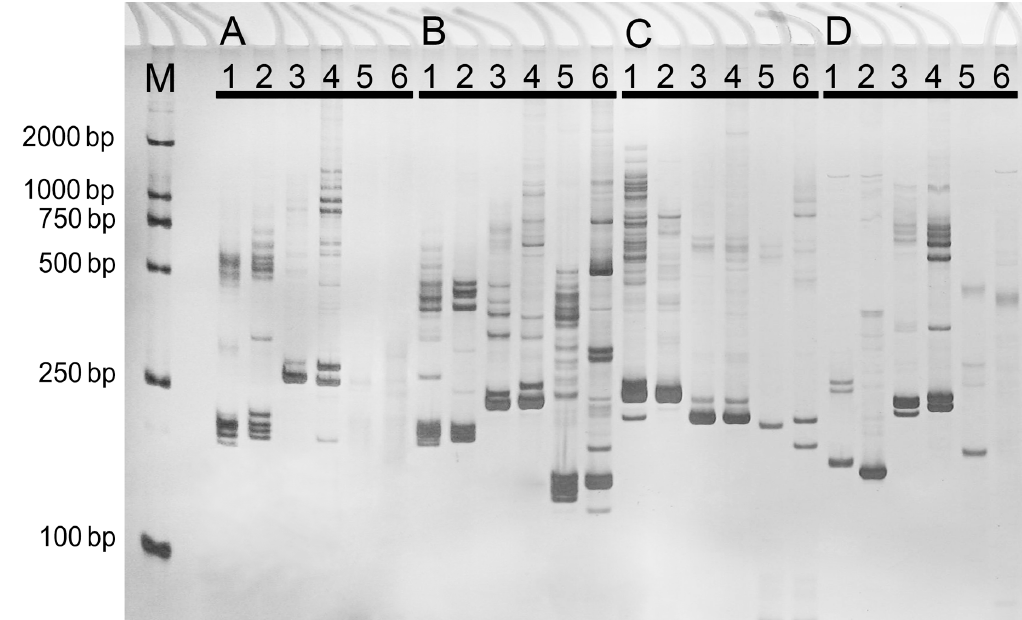
amplification. M: DNA Marker DL2000.